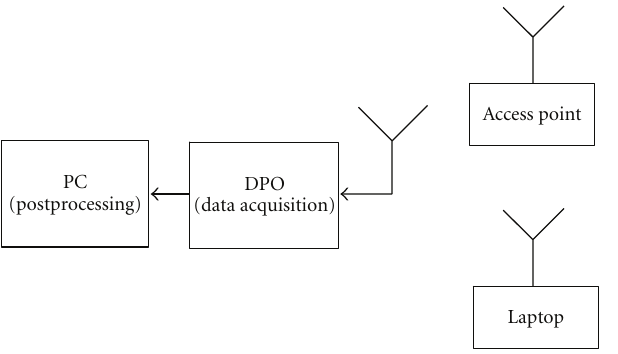
Figure 3: Setup of the measurement of Wi-Fi signals.